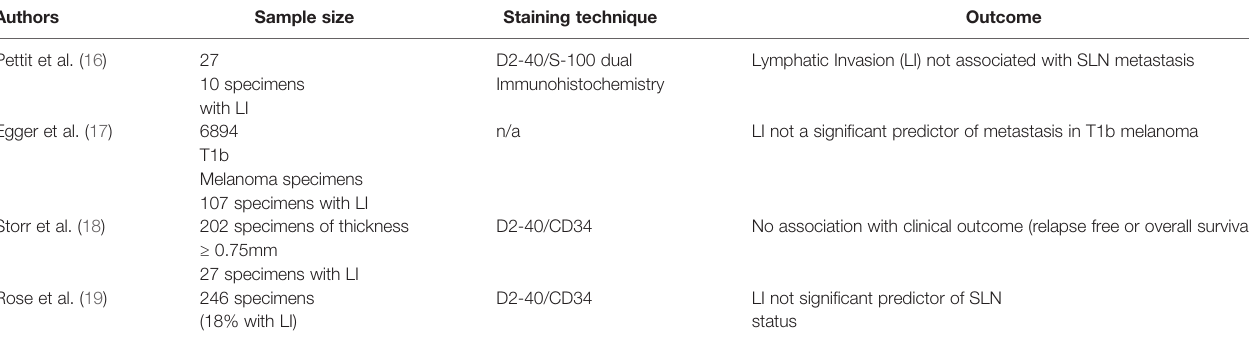
TABLE 2 | Studies concluding that lymphatic invasion does not predict